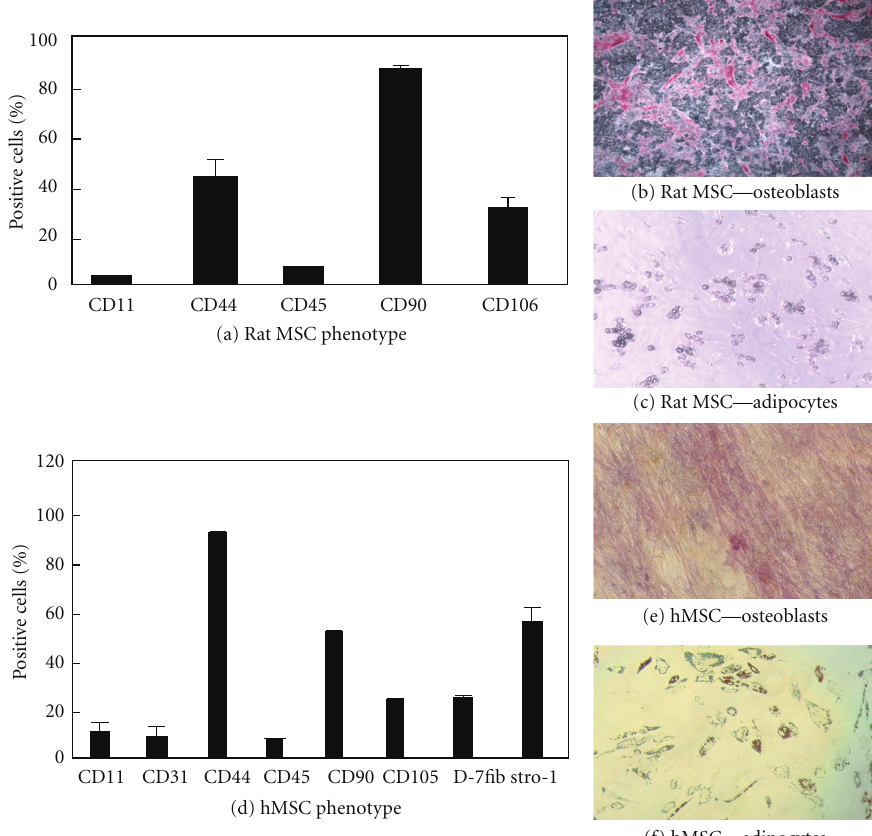
Figure 1: MSC validation. MSC isolated from humans and rats were immunophenotyped using typical MSC marker (Figures 1(a) and 1(b)), and the stem cell potential was confirmed by di ff erentiating them into adipocytes and osteoblasts (Figures 1(c) and